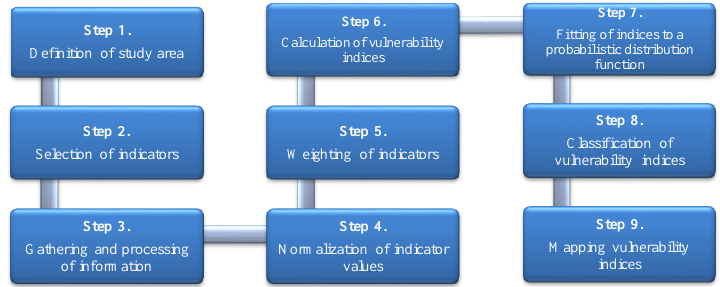
Figure 1. Drought vulnerability indices calculation method.